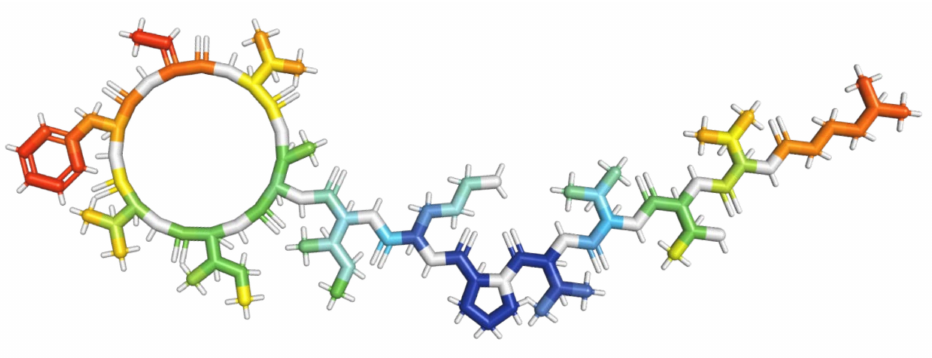
Figure 9. Model of kahalalide F: the only depsipeptide inducing oncosis in tumor cells. Table 8. Formula and molecular weight of kahalalide F, the only depsipeptide inducing oncosis in tumor